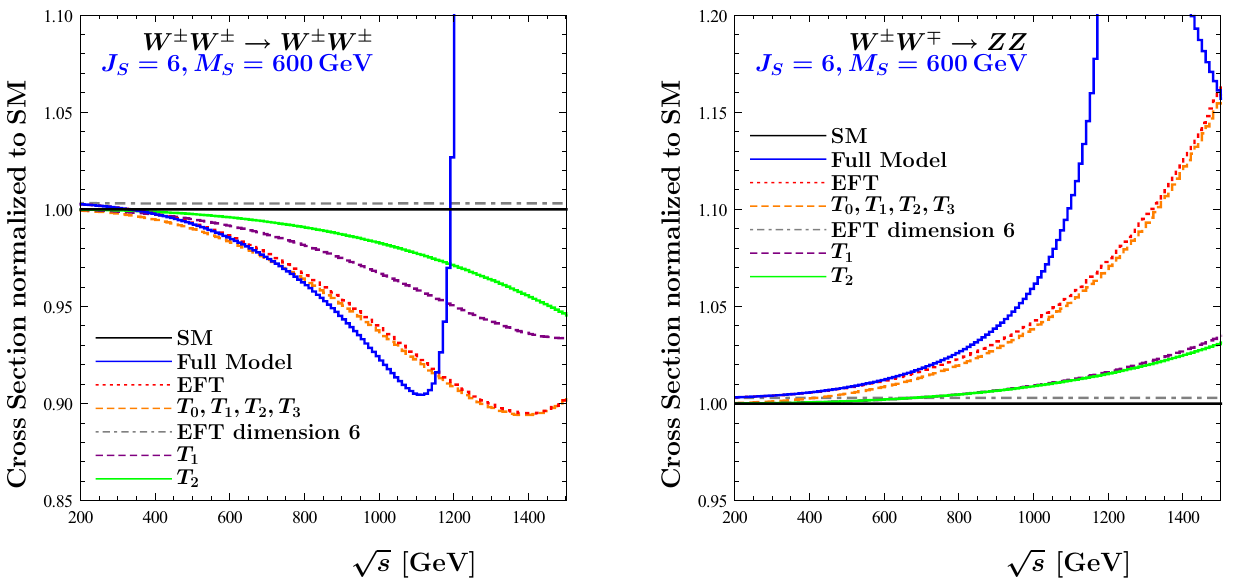
Fig. 8 Same as Fig.7, but for a single scalar multiplet with ( J S = 6 , M S = 600GeV )